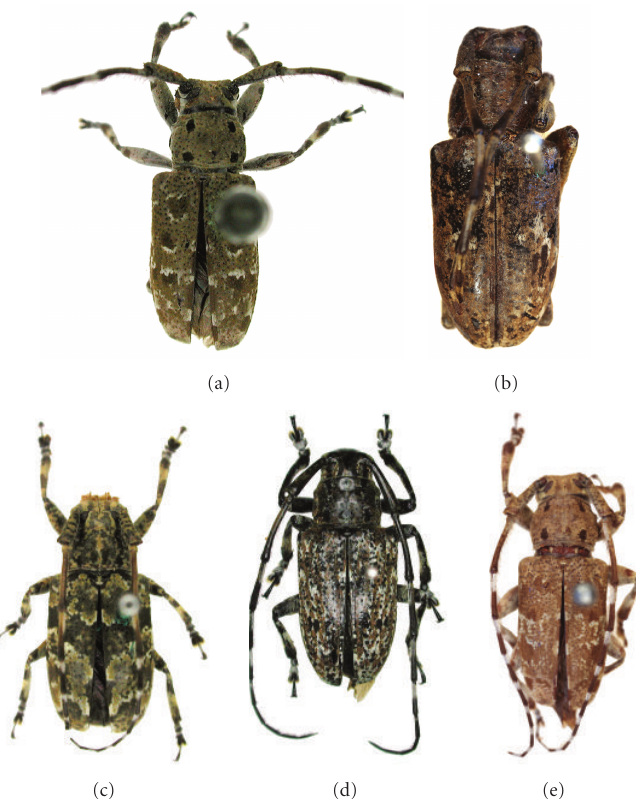
Figure 5: Habitus of Agelasta ( Dissosira ) spp. in dorsal view. (a) A. ( D. ) columba (syntype); (b) A. ( D. ) catenatoides (holotype); (c) A. ( D. ) gardneri (holotype); (d) A. ( D. ) nigropunctata ; (e) A. ( D. ) siamana (holotype).